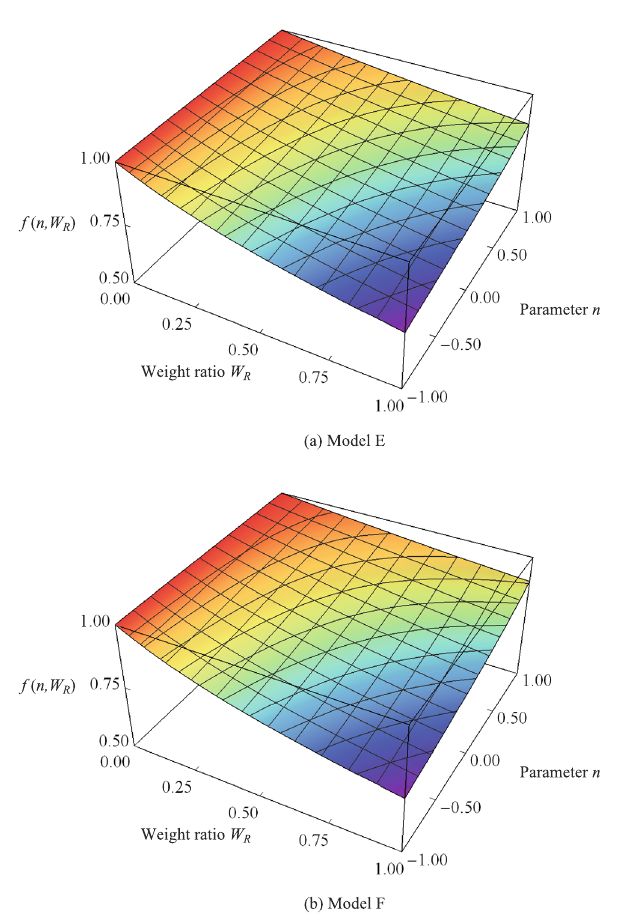
Figure 7. Relationship between the critical height and the branch distribution (contained in the weight